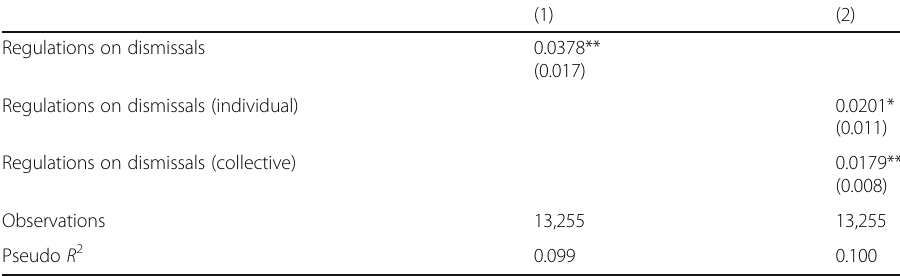
Table 5 Logit results of STW take-up: firm-specific characteristics + EPL indicators